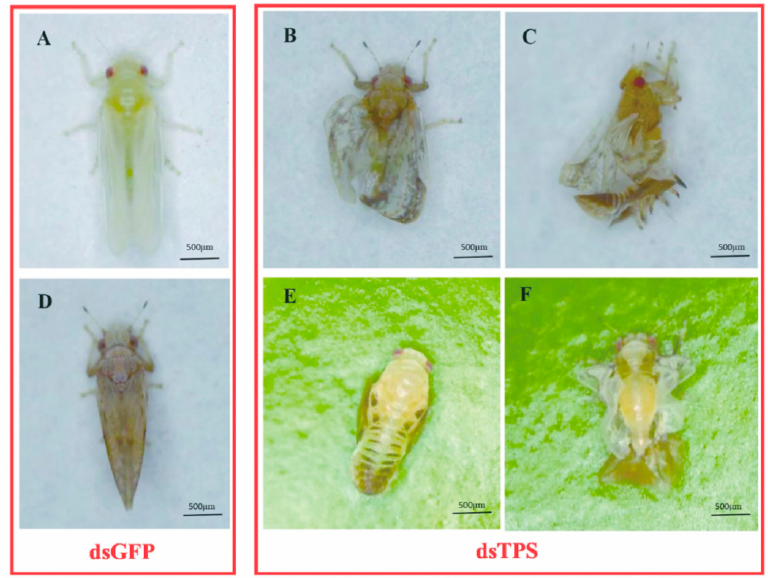
Figure 5. Effects of RNAi on D. citri representative phenotypes after feeding with dsRNA. ( A , D ) A newly emerged adult and mature adult come from the fifth-instar nymph treated with ds GFP (control). ( B , C , E , F ) D. citri that underwent metamorphosis after being treated with ds DcTPS .